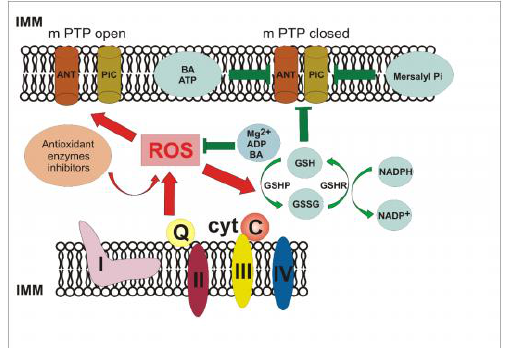
Figure 8. Hypothetic scheme of the yPTP in the E. magnusii mitochondria.